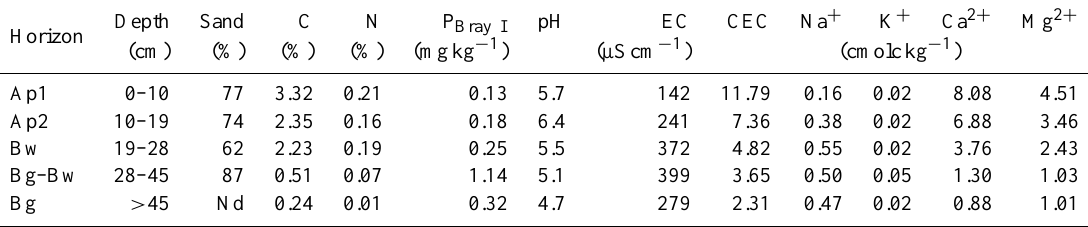
Nd = not determined. Table 2. Characteristics of the arenic Gleysol profile in Gunung Kleng. Horizon